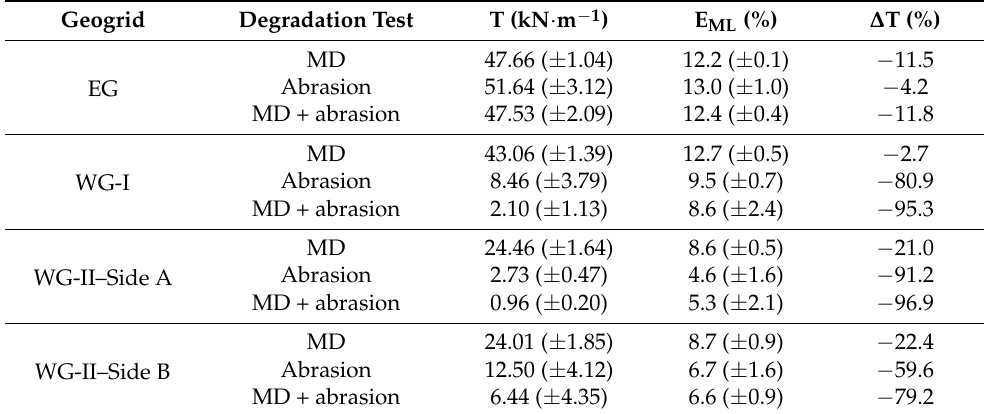
Table 3. Tensile properties and variations of the tensile strength of the geogrids after the degrada- tion